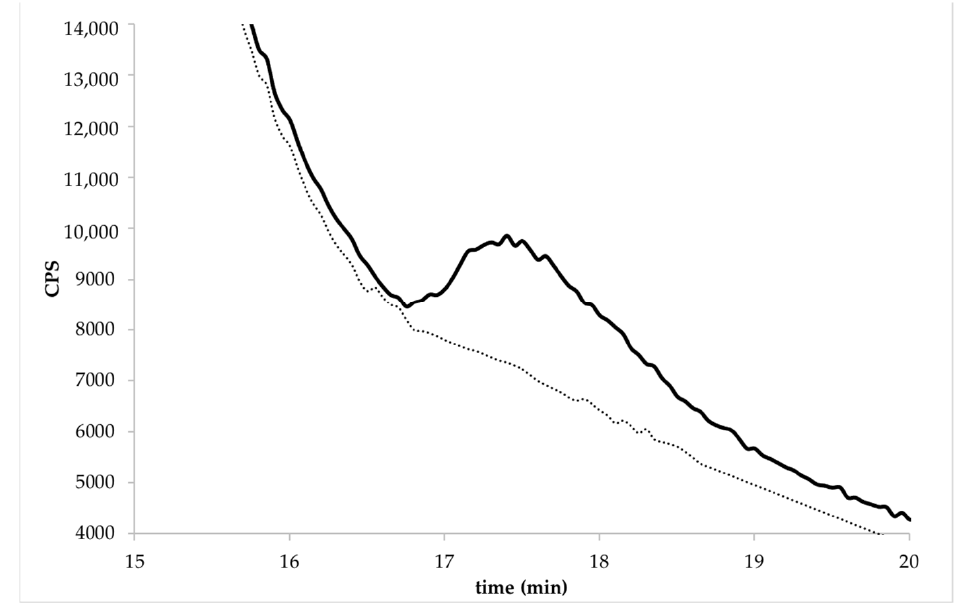
Figure 3. Chromatogram of BR (Barone variety) at the spiked level of 0.1 mg kg − 1 by HPLC-ICP- MS/MS. The dotted line represents the same un-enriched sample.